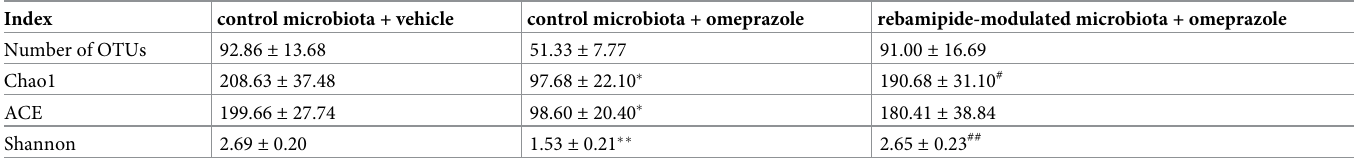
Table 3. α -diversity, measured by operational taxonomic unit (OTU) number, Chao1 index, ACE index, and Shannon’s diversity index of small intestinal lumen contents in microbiota-transplanted mice administered with